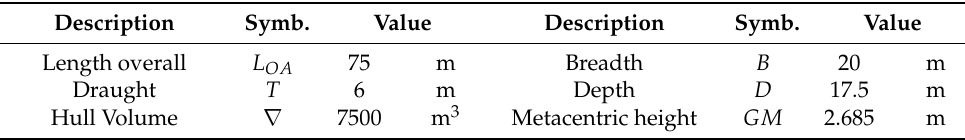
Table 1. Main particulars of test case arrangement.